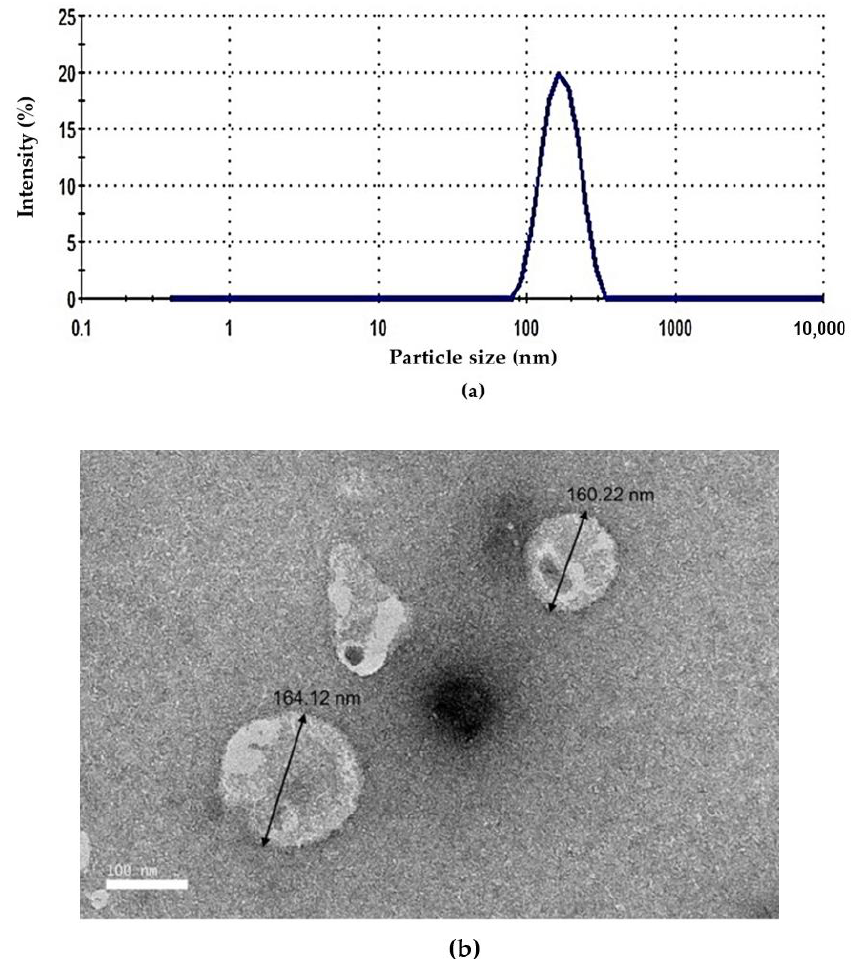
Figure 2. ( a ) The representative of the particle size distribution and ( b ) TEM images of the optimized NGC formulation at 25,000× magnification.